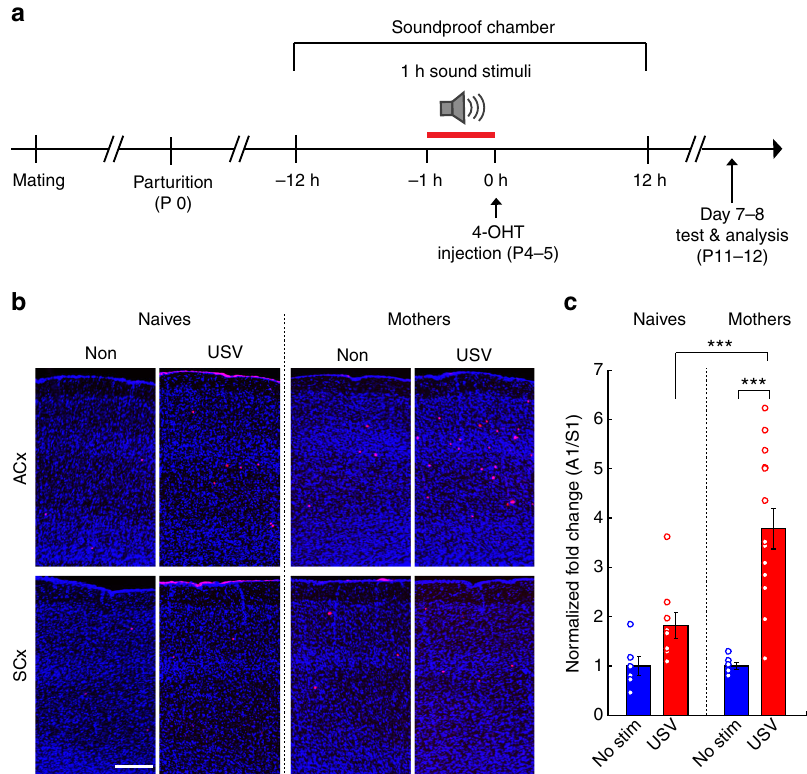
Fig. 4 Recruitment of additional USV-responsive neurons in A1 of mothers. a The experimental protocol for TRAPing in mothers. b Representative fl uorescent micrographs from the primary auditory (ACx, top rows) and somatosensory (SCx, bottom rows) cortices in naives and mothers. Each column shows images of ACx and SCx from the same mouse. The auditory stimulus is denoted above the images. c Quanti fi cation of the fold induction of TRAPed cells in A1 as compared to S1 (relative density), normalized to the ‘ No Stim ’ condition (mean ± SEM; Naives: same data as plotted in Fig. 1d; Mothers: ‘ No Stim ’ N = 6 mice, ‘ USV ’ N = 14 mice). USVs induced signi fi cantly higher number of the TRAPed cells than the relevant control group in naïves and mothers (*** p < 0.001, post hoc Fisher ’ s LSD test after signi fi cant two-way